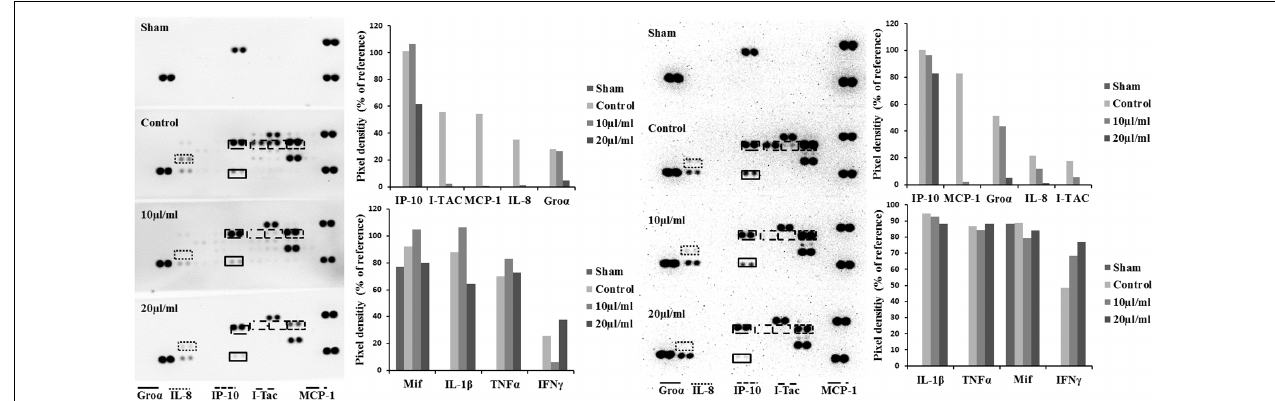
FIGURE 2 | Effect of STW5 and STW5 on the cytokine profile of NCM460 cells. Cells were treated with STW5 (left) or STW5-II (right) (10 or 20 µ l/ml) for 4 h prior to induction with the CM (10 ng/ml TNF- α , 5 ng/ml IL-1 β , and 10 ng/ml IFN- γ ) for 24 h. Supernatants were collected and analyzed by Proteome Profiler R (cid:13) and evaluated for Pixel density using ImageJ software.